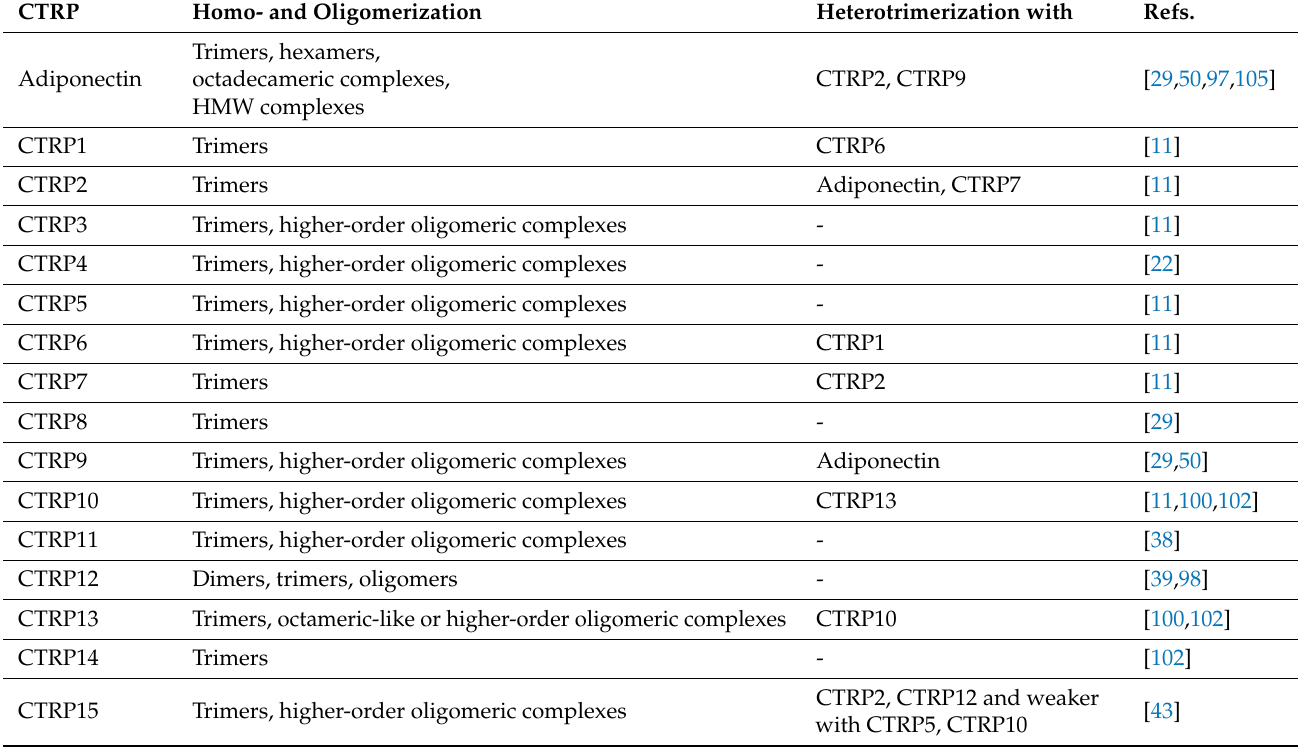
Table 3. CTRPs: homo- and